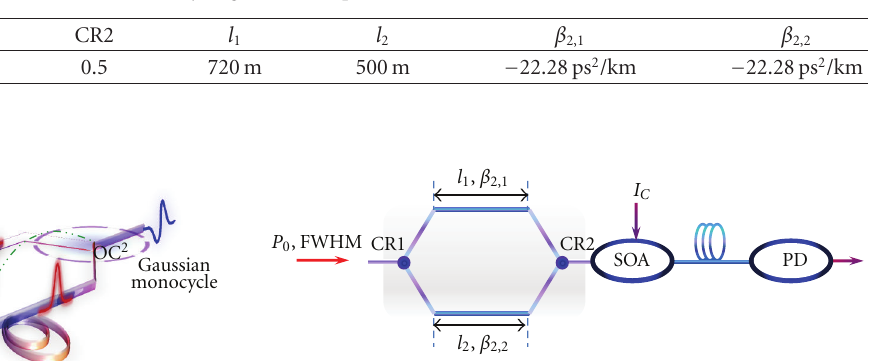
Table 2: Monocycle generation’s parameters.